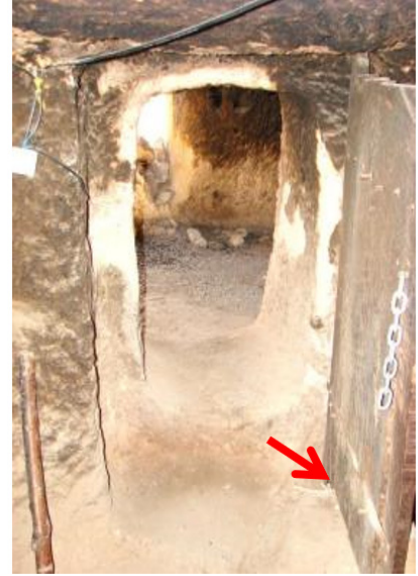
Figure 21. Details of a front door from inside.